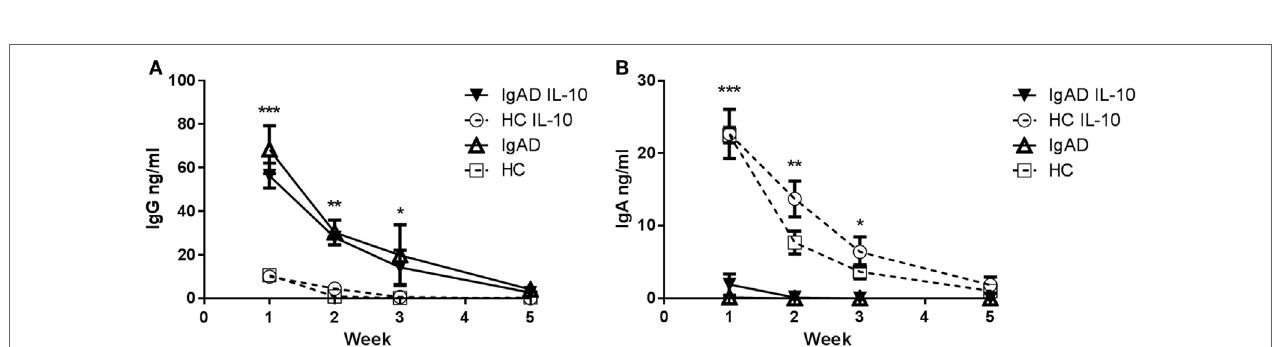
FigUre 6 | The IgA production induced by IL-10 does not result in a long-lived response in selective IgA deficiency (IgAD) individuals. The figure shows the antibody response of B cells from IgAD and healthy controls (HC) PBMCs with or without IL-10 stimulation as measured by enzyme-linked immunosorbent assay. (a) IgG production is statistically higher in IgAD individuals compared to HC at week 1 with production seen up to 5 weeks. (B) A small amount of IgA production is seen at week 1 in PBMCs from IgAD individuals with the exogenous addition of IL-10 (with— ▾ /or without IL-10 Δ ), it remains significantly lower at 1 week compared to HC (with— ○ /or without IL-10 ◽ ), with production seen up to the fifth week in HC but not IgAD. Significance was calculated in relation to the control group. * p < 0.05, ** p < 0.01, *** p < 0.001 (as determined by one-way